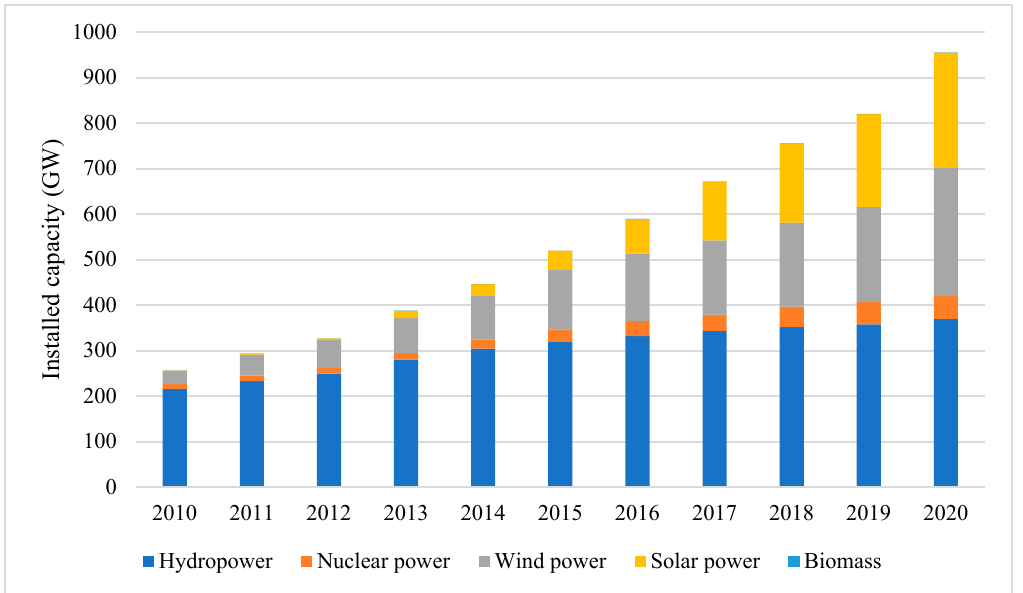
Figure 1. The installed capacity of renewable energy powers in 2010–2020. Source: China Statistical Yearbook, 2021.